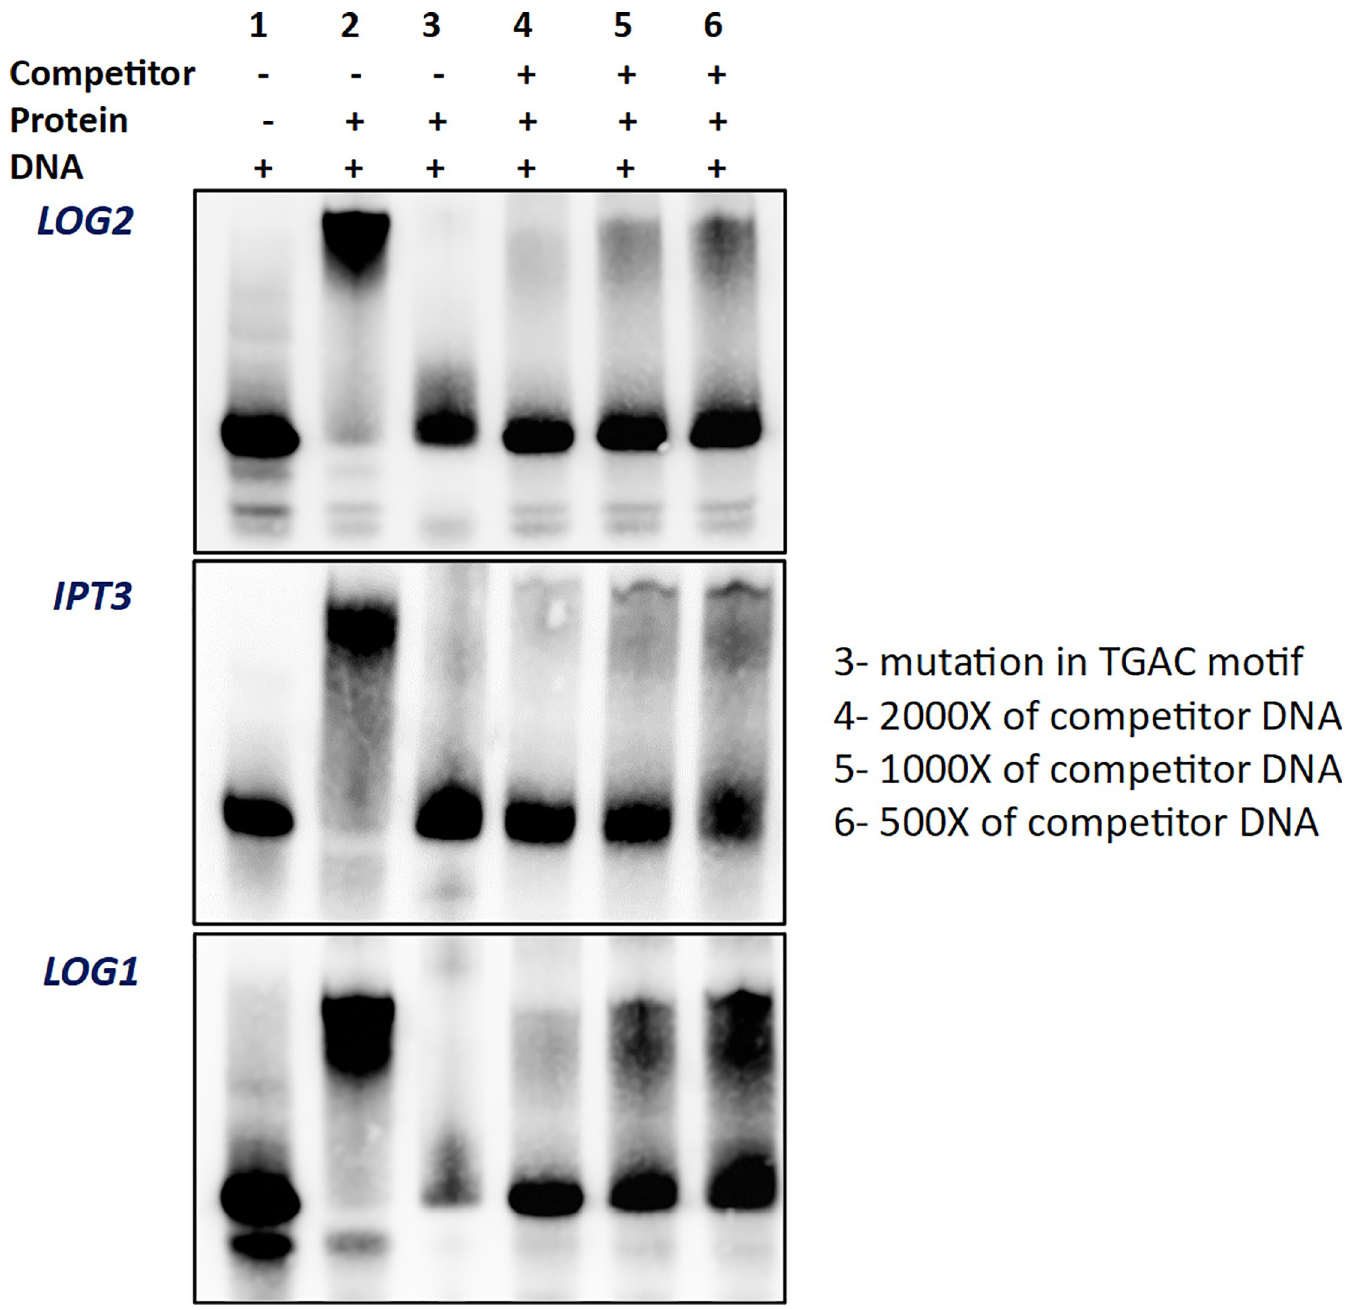
Fig 3. The results of EMSA experiment for the analysis of interaction between the homeodomain of MtKNOX3 and the regulatory sequences of the MtLOG2 , MtIPT3 , and MtLOG1 genes. 1- free ds-DNA, 2- ds-DNA with the protein, 3- mutated ds-DNA with the protein, 4- ds-DNA with the protein and 2000X of competitor DNA, 5- ds-DNA with the protein and 1000X of competitor DNA, 6- ds-DNA with the protein and 500X of competitor DNA. The protein amount is the same in all wells (1000